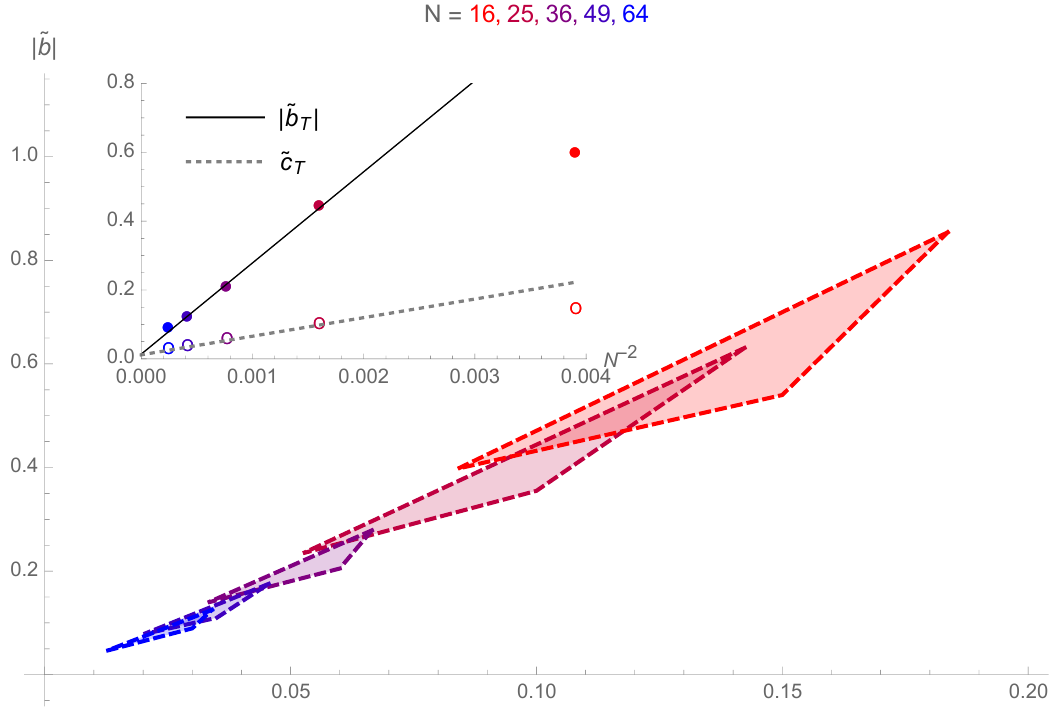
Figure 4 . The progression of triangles t N used to estimate the position of the triple point for various values of N . The results for N = 16 was not used in the extrapolation as this value of N seems to be too small and this result di(cid:11)ers from the clear trend set by the rest of the values, which are nearly perfectly (cid:12)tted by a linear function of N (cid:0) 2 , see the small statistical errors in table